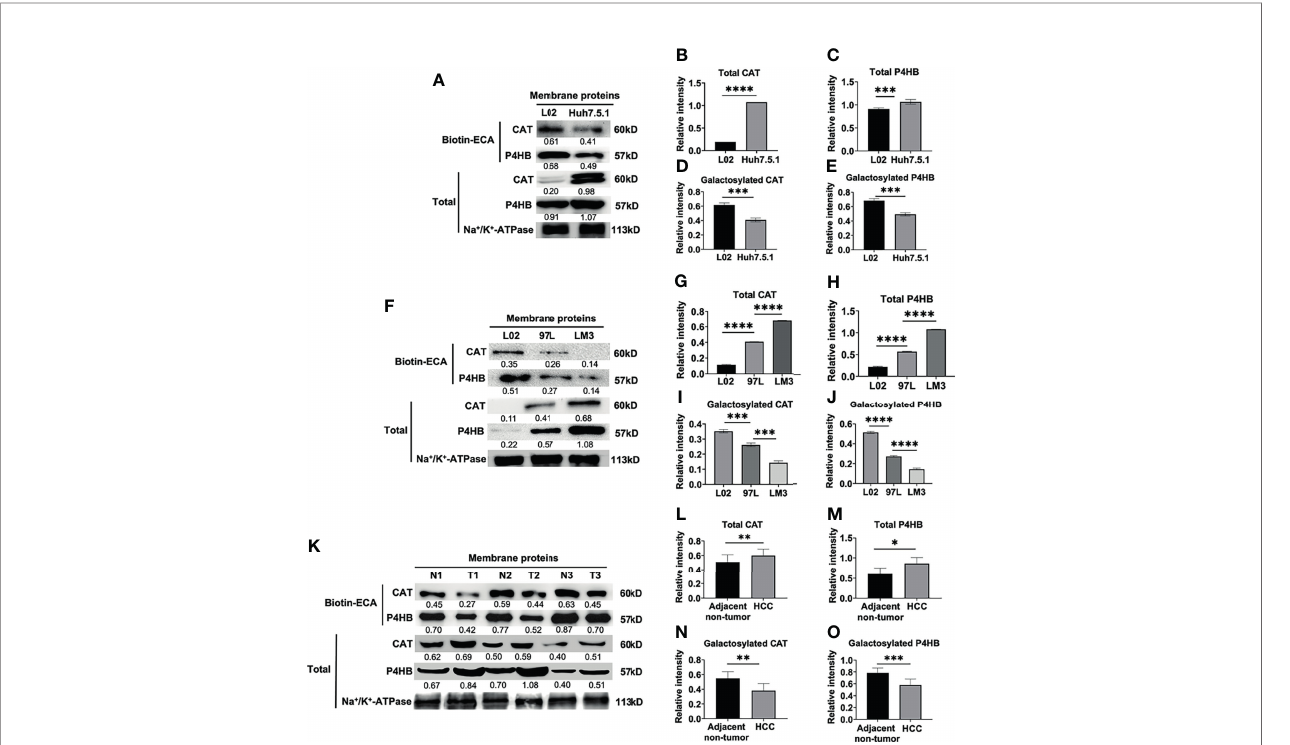
FIGURE 4 | Biotin-conjugated ECA pull down and western blot analysis of decreased membrane glycoproteins CAT and P4HB in different HCC cell lines and HCC tissues. (A – E) ECA lectin pull down and western blot analysis of membrane glycoprotein and total CAT and P4HB in human hepatocarcinoma cell line Huh7.5.1 and human normal liver cell L02. (F – J) Biotin-conjugated ECA pull down and western blot analysis of membrane glycoprotein and total CAT and P4HB from low metastatic cell (MHCC-97L), high metastatic cell (HCC-LM3) and human normal liver cell L02. (K – O) Biotin-conjugated ECA lectin pull down and western blot analysis of membrane glycoprotein and total CAT and P4HB from 3 HCC tissues (T) and adjacent non-tumor tissues (N) . P1, P2 and P3 represent HCC tissues from three patients; N1, N2 and N3 represent adjacent-non- tumor tissues from three HCC patients, respectively. (A, F, K) are the representative data for (B – E) , (G-J, L-O) , respectively. (B, D, I, L, N) (for CAT), (C, E, I. J, M, O) (for P4HB) are statistical analysis. Relative intensities based on endogenous membrane protein Na+/K+-ATPase are presented as the mean ± SD using unpaired Student ’ s t-tests for (B – E, L – O) , and using one way ANOVA followed by Sidak ’ s multiple comparisons test for (G – J) (* p < 0.05, ** p < 0.01; *** p < 0.001. **** p <